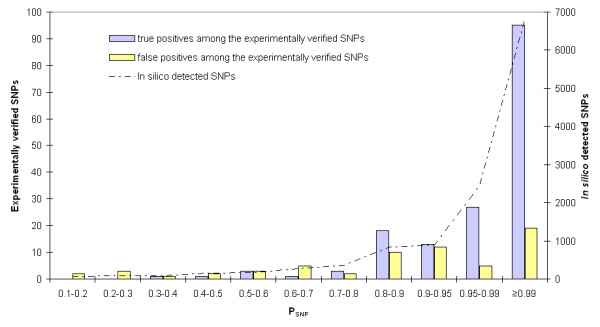
In silico detected SNPs and experimentally verified SNPs according to PSNP . A subset of the predicted SNPs was verified by the independant resequencing of fragments amplified from the genomic DNA extracted from the PG653 genotype. The sequence traces were manually inspected to verify the sites where SNPs were predicted by PolyBayes. Predicted SNPs that were indeed found in the genomic DNA sequence were called "true positives" (in blue on the figure), whereas the ones that were not verified were called "false positives" (in yellow on the figure).